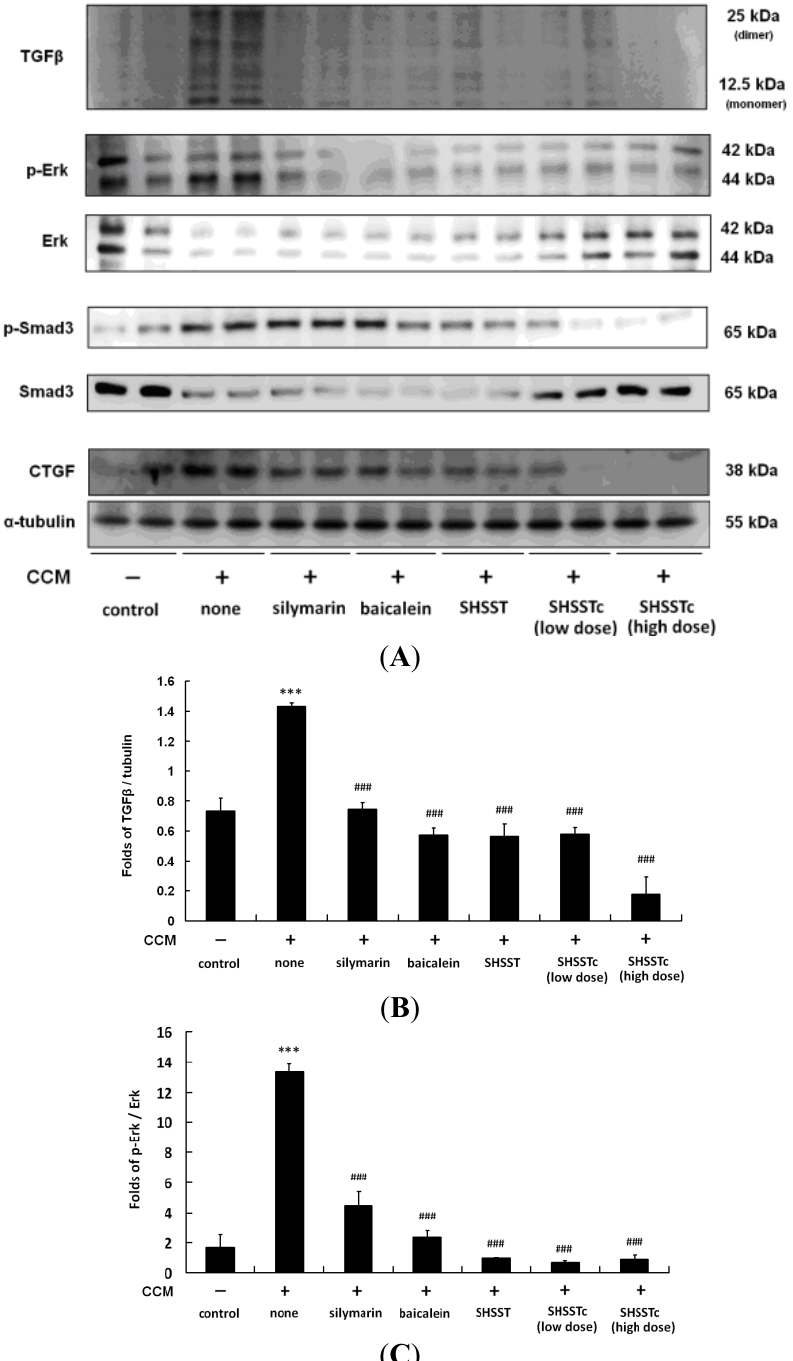
Figure 3. The transforming growth factor (TGF)- β pathway protein expression level analysis. ( A ) TGF- β /phoshphorylated mothers against decapentaplegic homolog 3 (Smad-3)/connective tissue growth factor (CTGF) expression levels were increased in CCM and reduced by silymarin, baicalein, SHSST, and SHSSTc low and high dose treatments; ( B ) The normalized TGF- β protein expression folds with α -tubulin; ( C ) The normalized protein expression folds of p-Erk with Erk; ( D ) The normalized protein expression folds of p-Smad3 with Smad3; ( E ) The normalized protein expression folds of CTGF with α -tubulin. n = 6; * p < 0.05, *** p < 0.001 compared with control group; ### p < 0.001 compared with the CCM